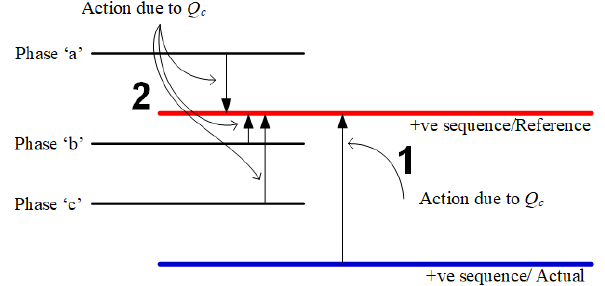
Figure 4. Possible compensation alternatives for available reactive power from the inverter 𝑄 𝑖 .